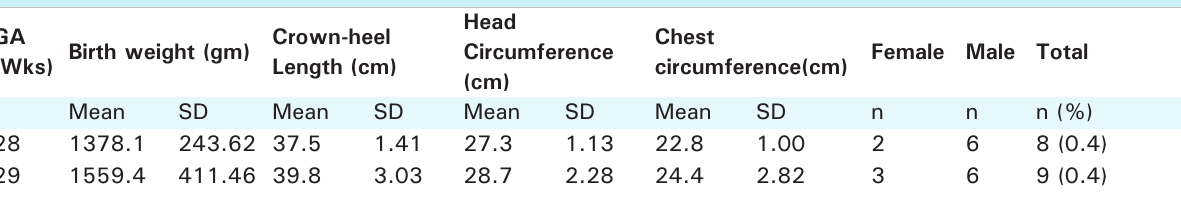
Table 1. Mean birth weight, mean CHL, mean HC, mean CC and their standard deviations. GA Crown-heel Birth weight (gm) (Wks) Length